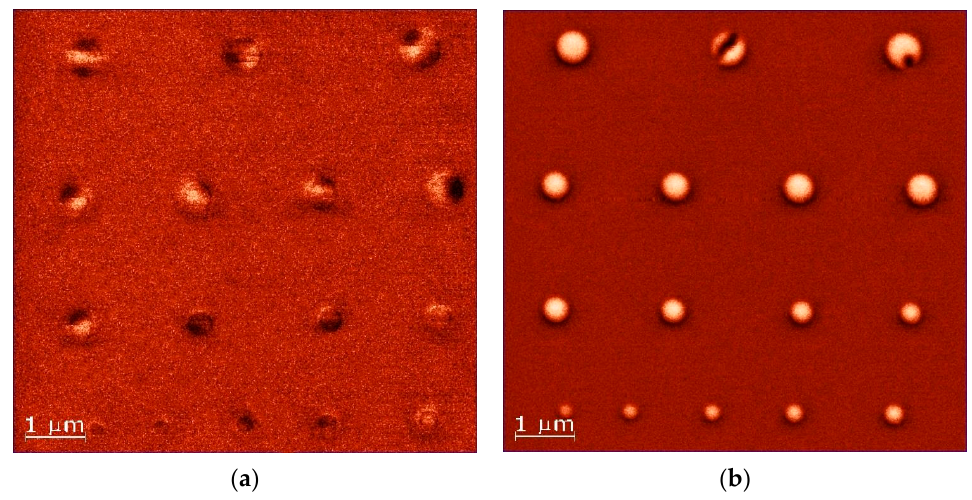
Figure 3. The figure shows the distribution of magnetization in nanodots taken by LM tip, which was done before ( a ) and after ( b ) scan by HM tip. Figure ( a ) shows complex domain structures, including horseshoe domains (i.e., 525, 500, 475, 375 nm), while figure ( b ) shows single-domain states in all dots with a diameter smaller than 500